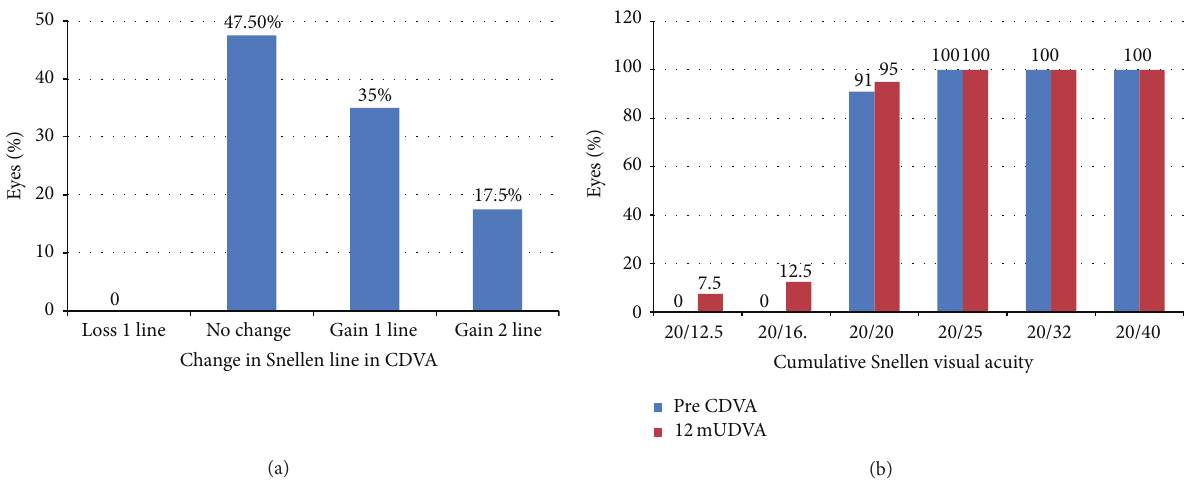
Figure 1: Change in Snellen lines of CDVA (CDVA: corrected distance visual acuity; SE: spherical equivalent) and cumulative Snellen visual acuity.